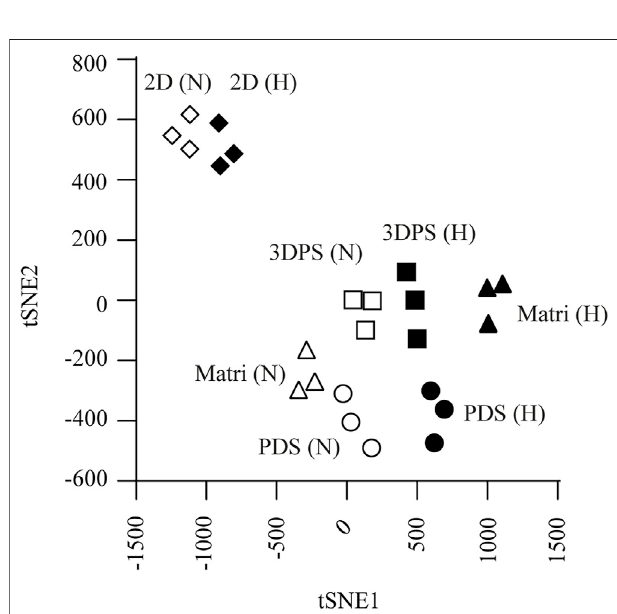
FIGURE2| Cellculturesystemsevaluatedbyt-SNEanalysis.Cellswere cultured in normoxia (N, hollow symbols) or hypoxia (H, solid symbols) in patient-derived scaffolds(PDS, circles),3D printed scaffolds (3DPS,squares), Matrigel (M.Gel, triangles), or 2D (diamonds). Each dot indicates an individual experiment including 3 replicates